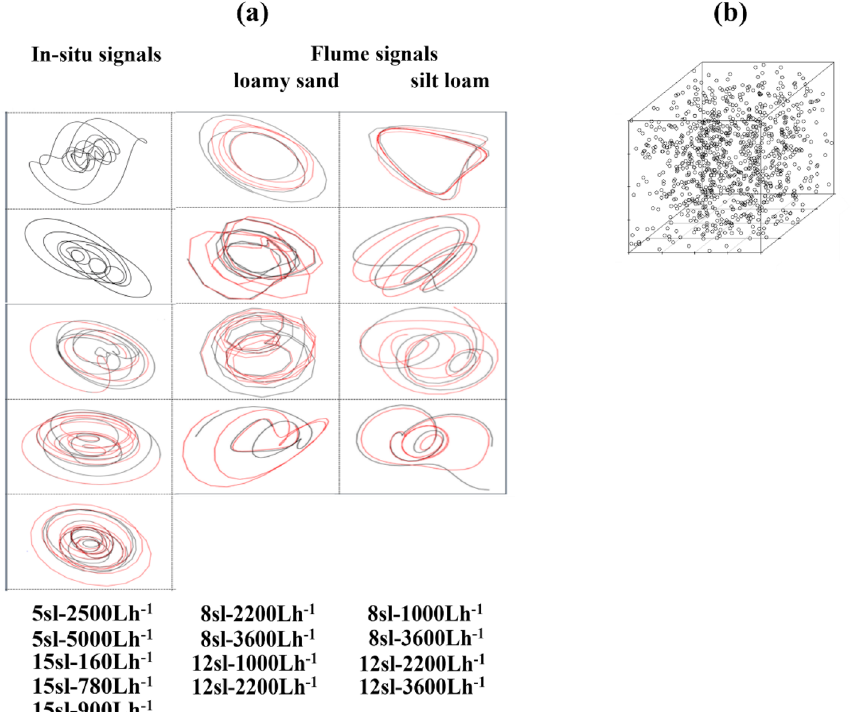
Figure 4. Screening for emergent nonlinear-deterministic dynamics in rill signals. ( a ) We reconstructed low- dimensional shadow attractors from all five in-situ rill signals, and from eight of the ten flume rill signals whose flow discharge levels exceeded 1000 Lh −1 (black trajectories). The two failed shadow attractors had too few orbits to adequately sample an underlying attractor, possibly indicating failure of the associated flume rill profiles to develop step-pool units. All reconstructed attractors required at least from two to four embedding dimensions (Table 2), indicating low-dimensional nonlinear dynamics. The plots of shadow attractors have a cyclical appearance composed of aperiodic non-repeating oscillations. In a demonstration of dynamic correspondence, state-space trajectories reconstructed from echo state neural network out-of-sample forecasts (red trajectories) largely rest on shadow attractors reconstructed from in-sample rill signals (black trajectories). Echo state neural network models fit to in-situ rill signals 5 sl–2500 Lh −1 and 5 sl–5000 Lh −1 were explosive for wide ranges of sampled hyperparameter values, and thus not used for forecasting. ( b ) The visual geometric structure of shadow attractors stands out in contrast to a random scattering of points resulting from reconstruction of a